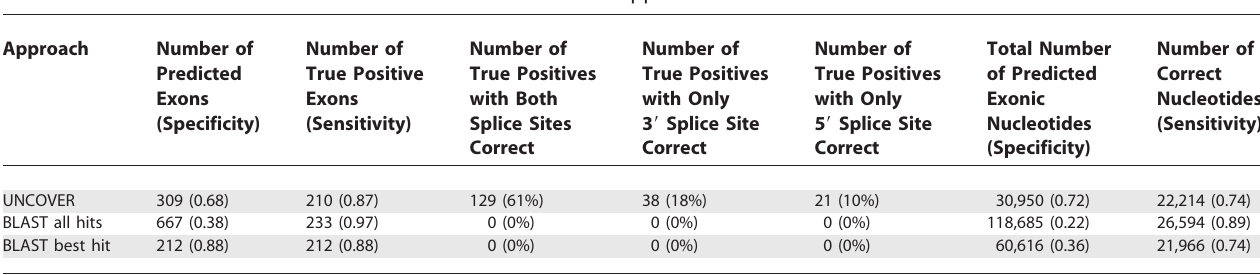
Table 1. Prediction Results on a Known Set of 241 Conserved Skipped